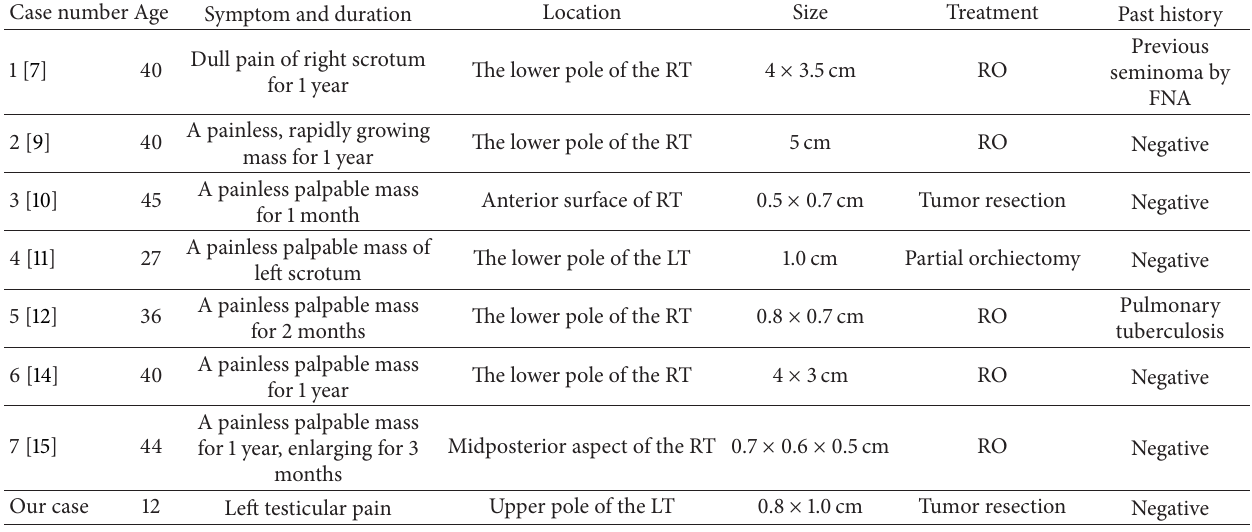
Table 1: Characteristics and clinical course of published cases of AT from tunica albuginea.